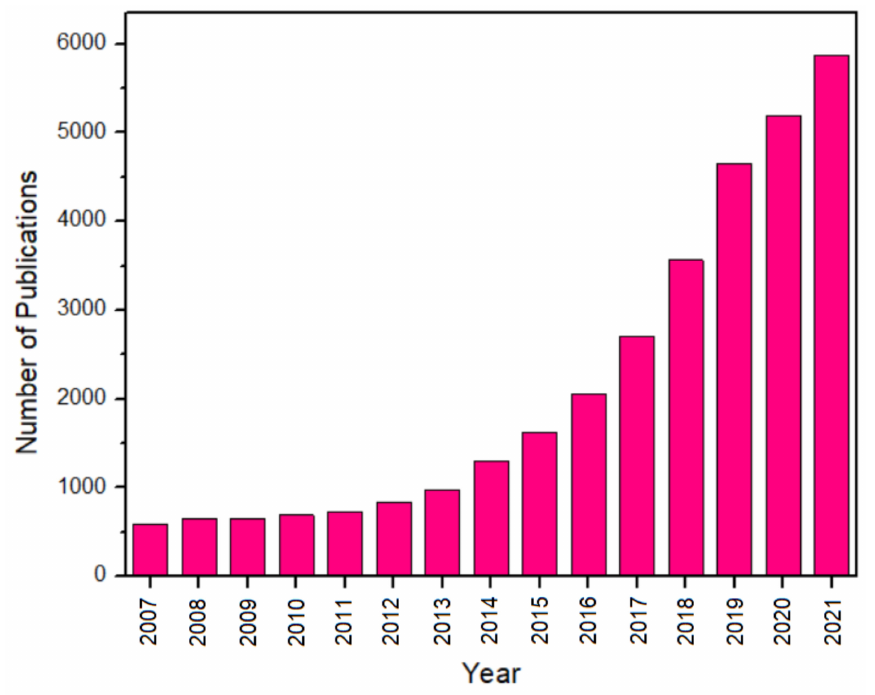
Figure 2. The number of publications using “carbon nitride*” or “g-C 3 N 4 *” as the topic keywords in the past 15 years. Adapted from ISI Web of Science (WoS) (date of search: 16 March